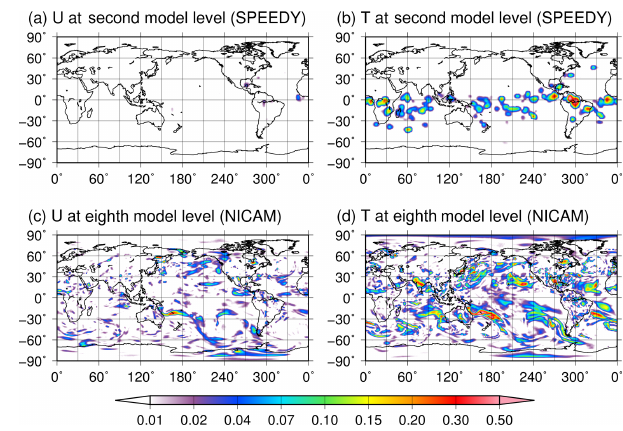
Figure 20. Spatial distributions of background KL divergence for the SPEEDY and NICAM models. Upper panels show (a) zonal wind and (b) temperature at the second model level ( ∼ 850hPa) for the SPEEDY model at 00:00UTC on 1 March. Bottom panels show (c) zonal wind and (d) temperature at the eighth model level ( ∼ 850hPa) for NICAM at 00:00UTC on 8 November